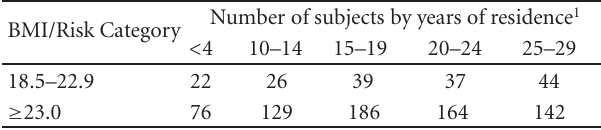
Table 2: BMI/Risk category of subjects by years of residence in